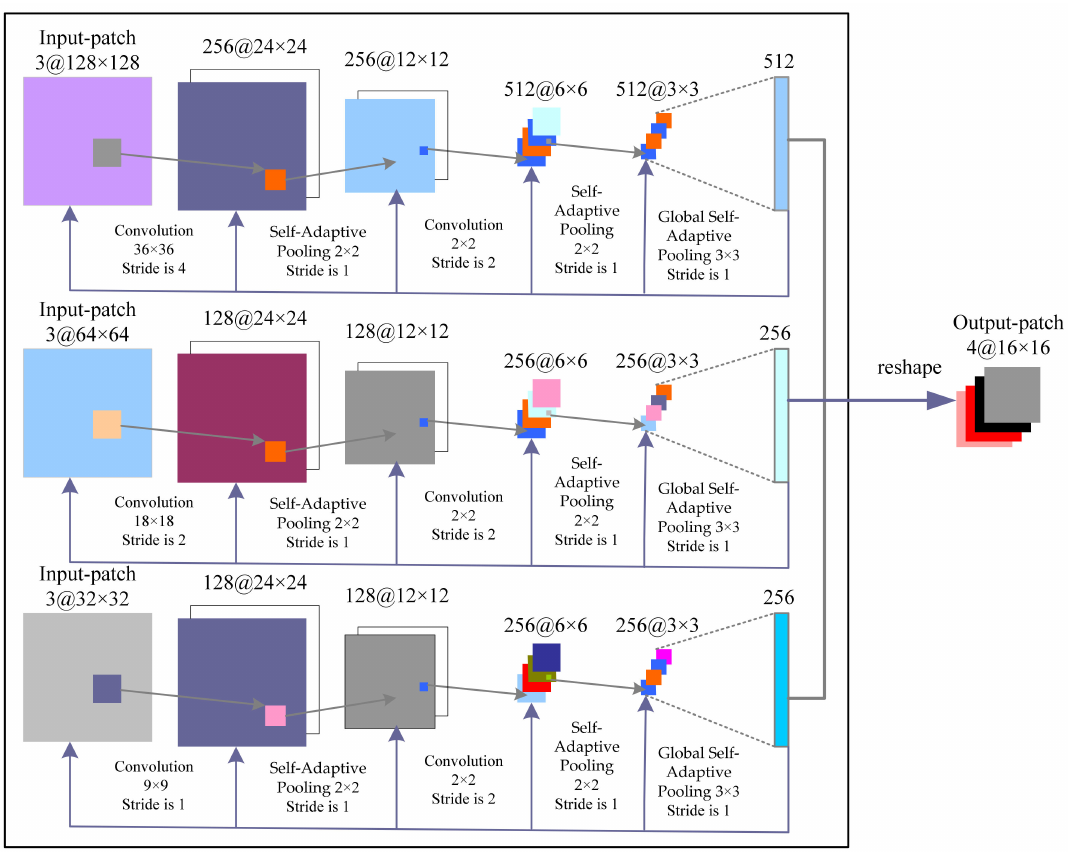
Figure 7. The architecture of our designed multiple